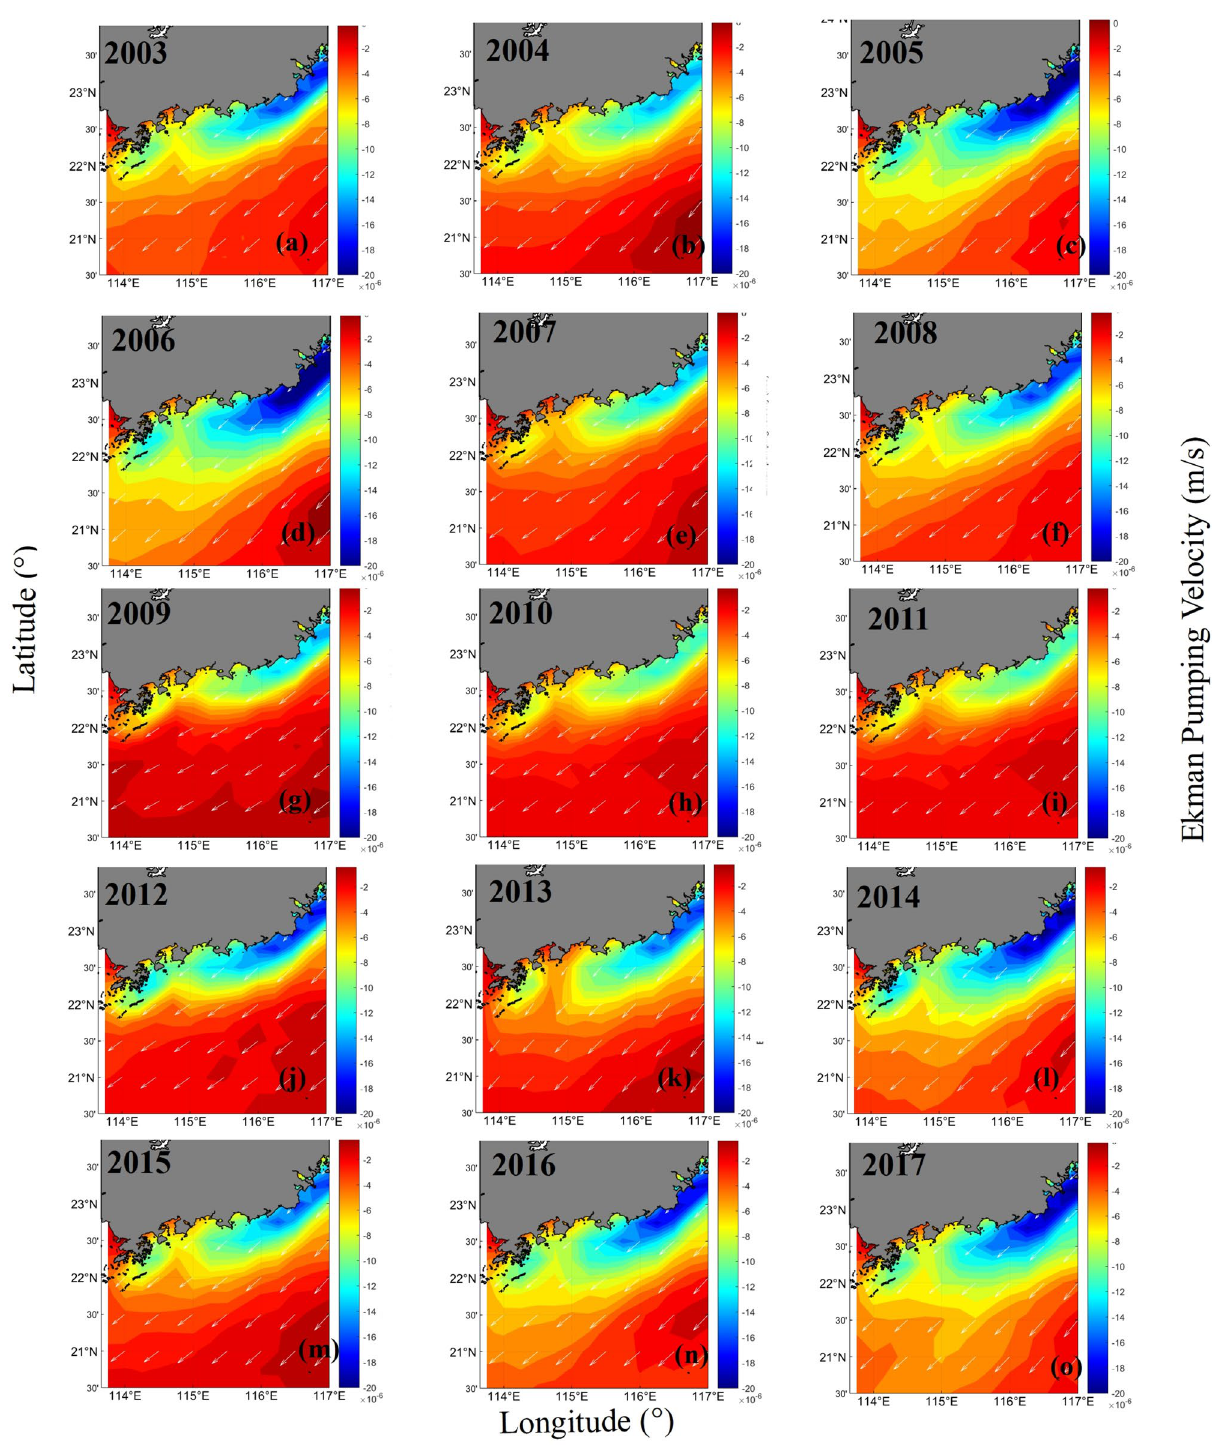
Figure 6. The mean Ekman pumping velocities (m s −1 ) between November and December from 2003 to 2017 (a positive value denotes upwelling, and a negative value denotes downwelling). The program R (version 3.6.3, available at https:// www.r- proje ct. org) was applied for the